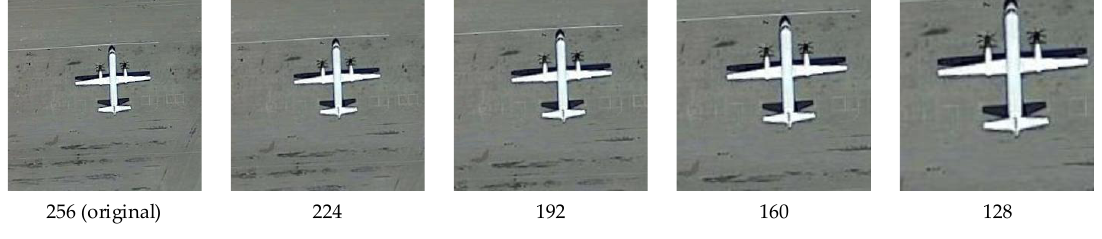
Figure 17. Example of cropped and resized images. Table 8. The mean attention difference in different scales on the UC Merced dataset. Scale of Cropped Samples